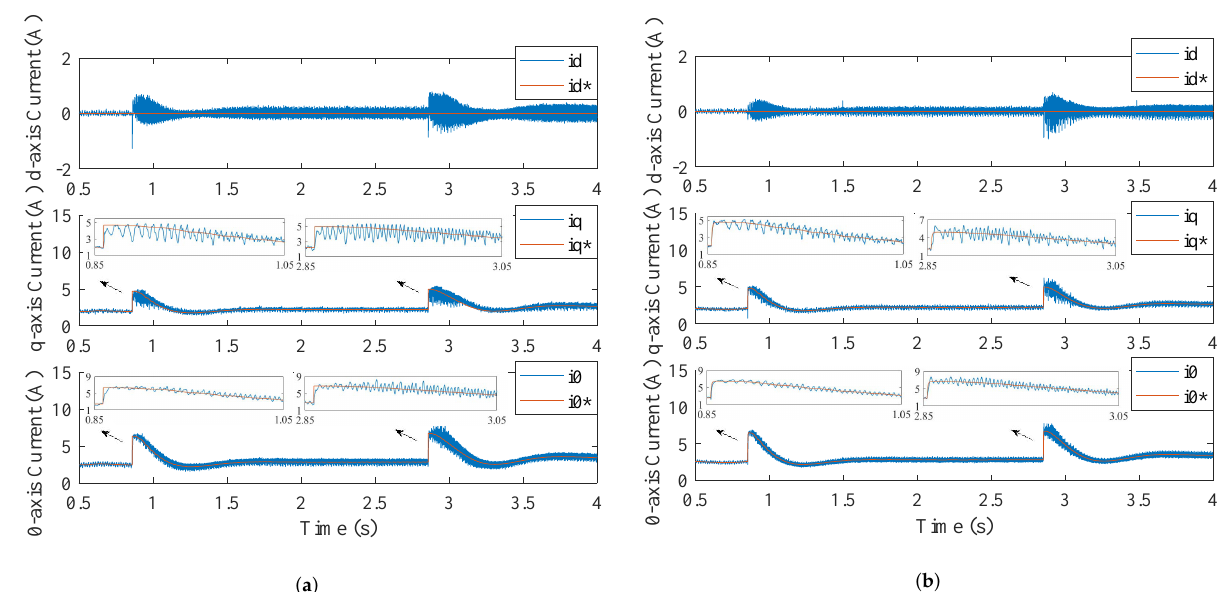
Figure 6. Experimental results of the dq 0-axes current when the speed changes. ( a ) Method in [14]. ( b ) 2DOF IMC ADO method.